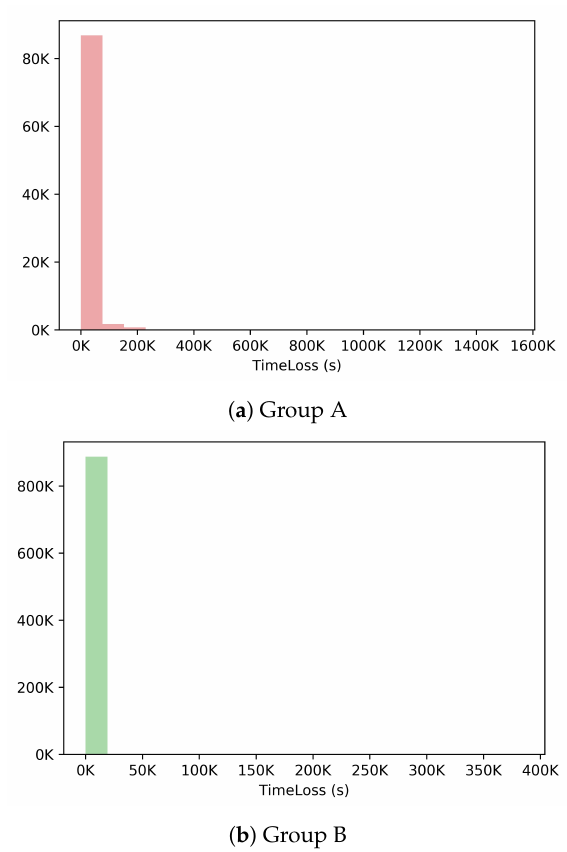
Figure 12. TimeLoss of preempted